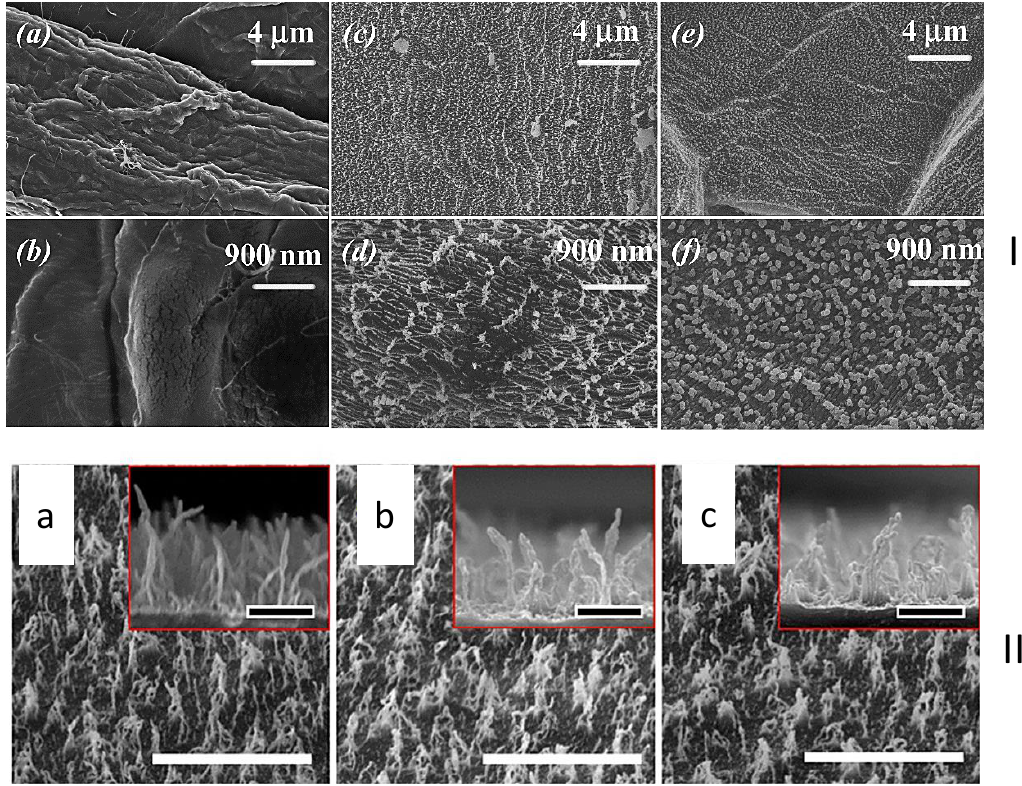
Figure 6. ( I ) SEM images of ( a , b ) untreated, ( c , d ) oxygen-etched, and ( e , f ) oxygen-etched and FC-coated hand sheet fiber. Adapted with permission from [54]. Copyright 2008, American Chemical Society. ( II ) SEM images of oxygen plasma-etched dodecyl benzenesulfonate-doped polypyrrole (PPy(DBS)) surfaces without preheating ( a ), pre-heat treated at 100 ◦ C ( b ) and pre-heat treated at 200 ◦ C ( c ). The scale bars in the main images and the insets are 1 µ m and 500 nm, respectively. Adapted with permission from [57]. Copyright 2017 American Chemical Society.